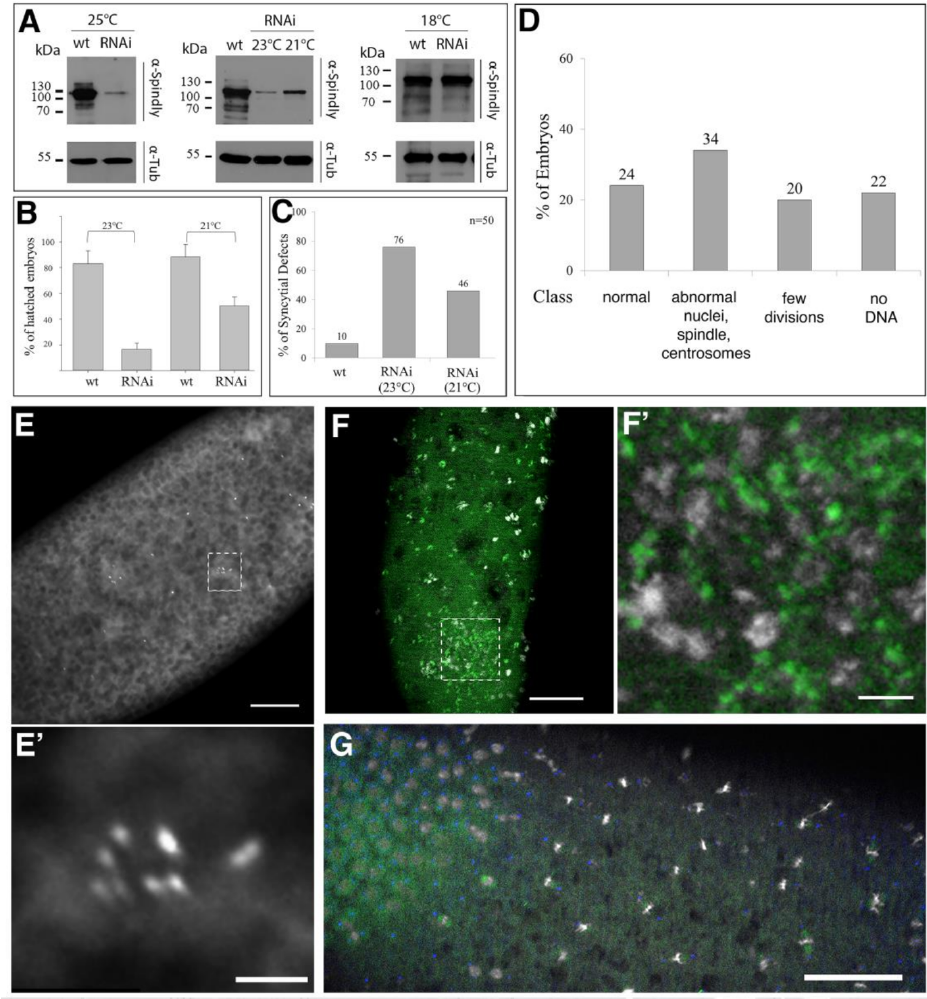
Figure 3. Phenotype of nos >>Gal4 driven Spindly knock-down. ( A ) Immunoblot analysis of protein lysates of 0–3 h old w 1118 embryos (wt) or spindly [ nos >RNAi] (RNAi) embryos at different temperatures (loading control— α -Tubulin (Tub); molecular weight standards in kDa); ( B ) Viability of spindly [ nos >RNAi] scored by larval hatching rate ( n = 100; data represent 3 independent replicates); ( C ) Penetrance of mitotic arrests in syncytial divisions of spindly [ nos >RNAi] embryos featuring phenotypes described in ( D – G ); ( D ) Expressivity of syncytial cleavage defects of spindly [ nos >RNAi] embryos at 23 ◦ C. Occurrence of phenotypic classes of spindly [ nos >RNAi] embryos ( n = 50); ( E ) Syncytial stages with patches of multiple centrosomes (anti-Centrosomin staining); ( E’ ) higher magnification of boxed area in ( E ); scale bars: 50 µ m ( E ) and 10 µ m ( E’ )); ( F ) Condensed chromatin associated with patches of tubulin (detail indicated by yellow box; DAPI (grey), beta-tubulin (green), scale bars represent 50 µ m ( F ) and 10 µ m ( F’ )); ( G ) Asynchrony of mitotic divisions, as indicated by an area of mitotic divisions and areas enriched in interphase nuclei (scale bar: 50 µ